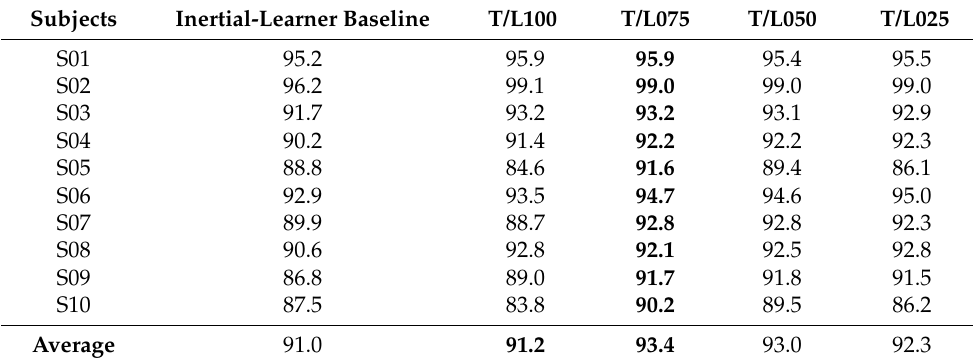
Table 7. Relationship to compare the performance of the inertial-learner average classification (expressed in percentage) model trained over the T/L approach in contrast to the baseline. Subjects Inertial-Learner Baseline T/L100